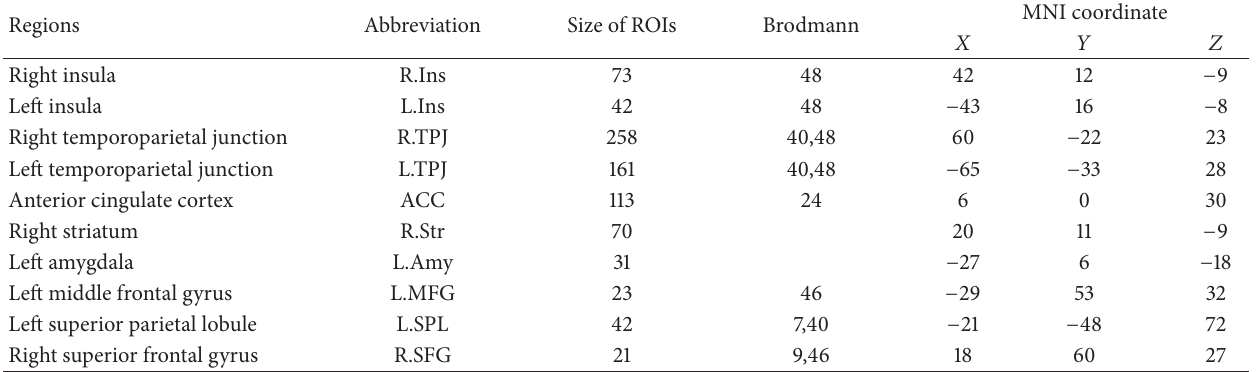
Table 1: Ten ROIs determined in local FCD